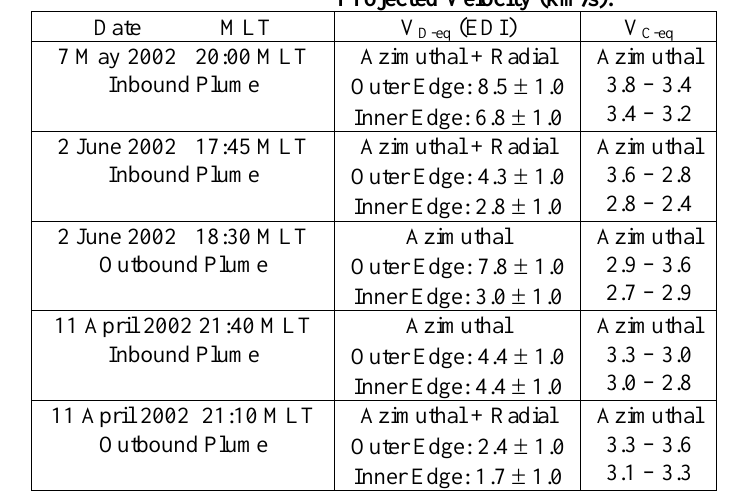
Table 5. Comparison between the velocities determined from EDI projected onto the equatorial plane and the projected co-rotation velocity for the three